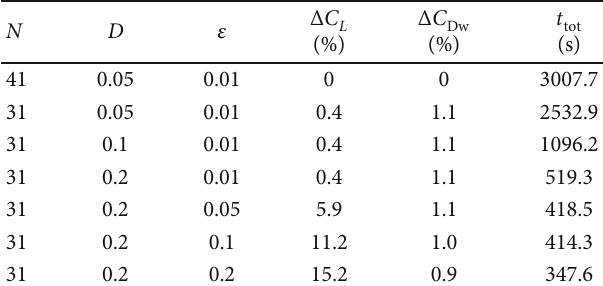
Figure 9: x -wall shear stress contours of the aerodynamic analysis tool and ANSYS-Fluent for 18 ° . Table 1: E ff ect of N , D , and ε to the results and t tot